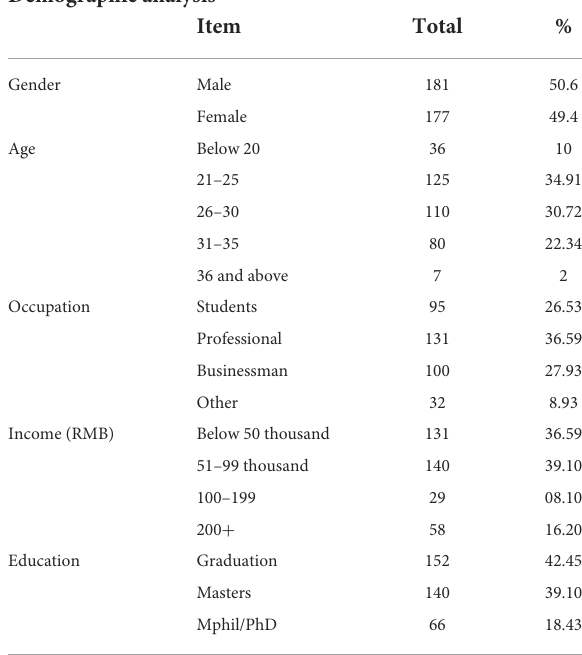
TABLE 1 The demographic detail of survey